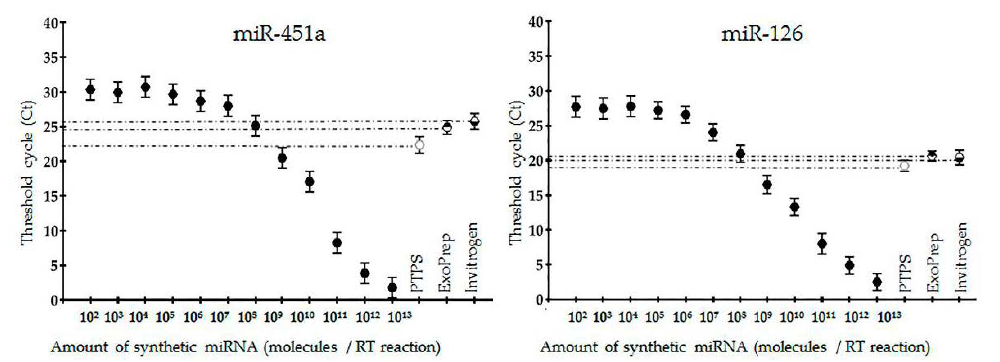
Figure 11. OT-qPCR analysis of miRNA in ENVs isolated by PTPS and commercial